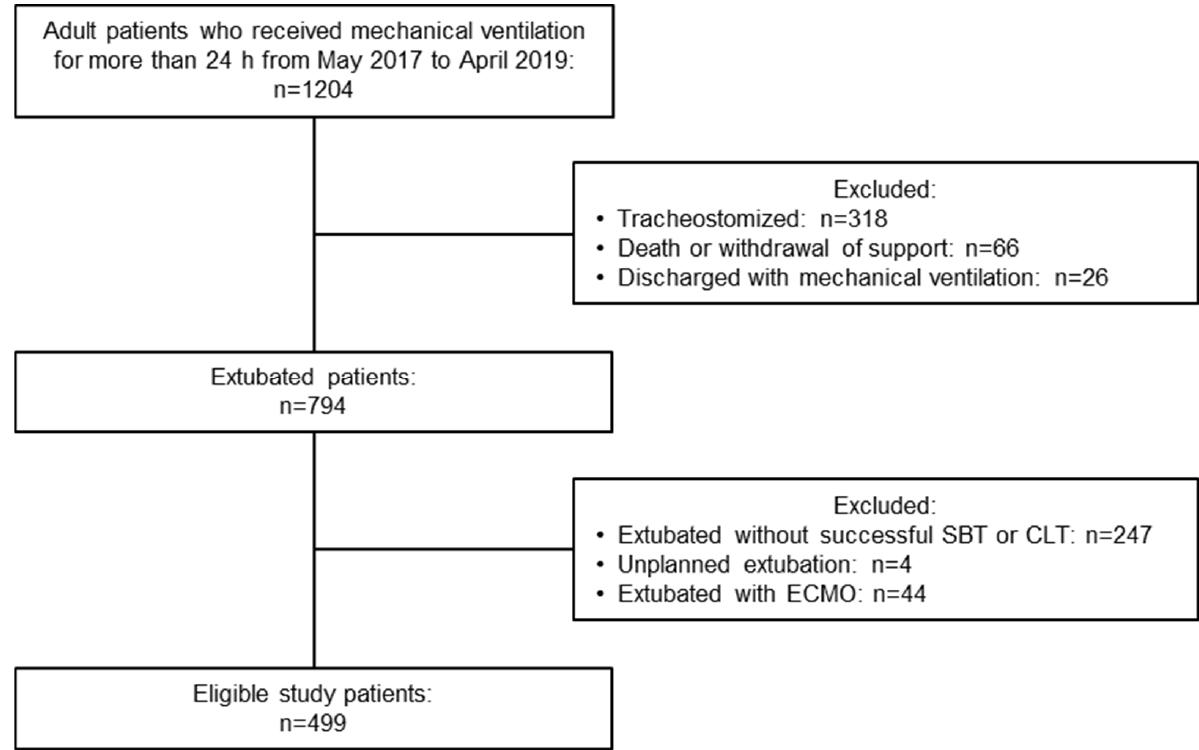
Figure 1. Flowchart of the study patients. SBT, spontaneous breathing trial; CLT, cuff leak test; ECMO, extracorporeal membrane oxygenation.